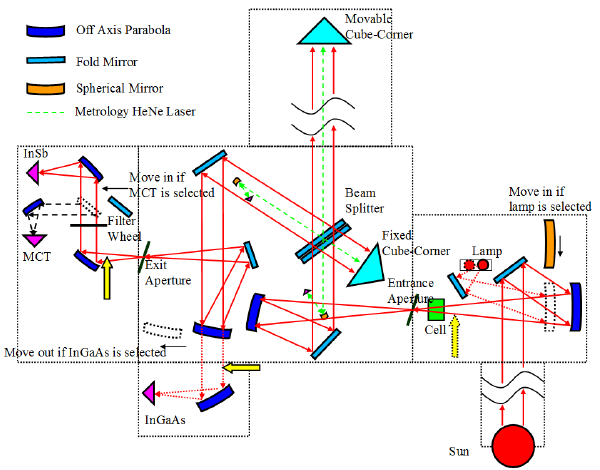
Figure 1. Schematic drawing of the instrument with all its mirrors. The yellow arrows show the place where the attenuators are in- serted. The solid yellow arrows are for the group one experiments; i.e., the attenuator was inserted to a specified place just in front of the exit parabolic mirror. The dotted yellow arrow is for the group two experiments; i.e., the attenuator was inserted to a specified place between the entrance parabolic/spherical mirror and its focus (i.e., the position of the 1mm entrance field stop).